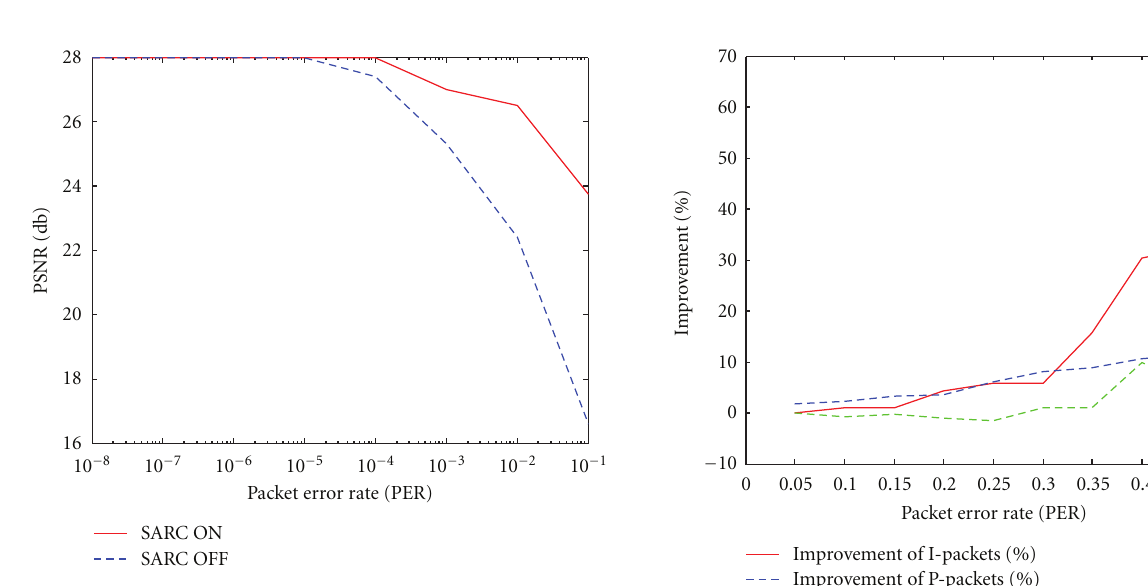
Figure 5: Quality of “Foreman” video clip for di ff erent error rates.